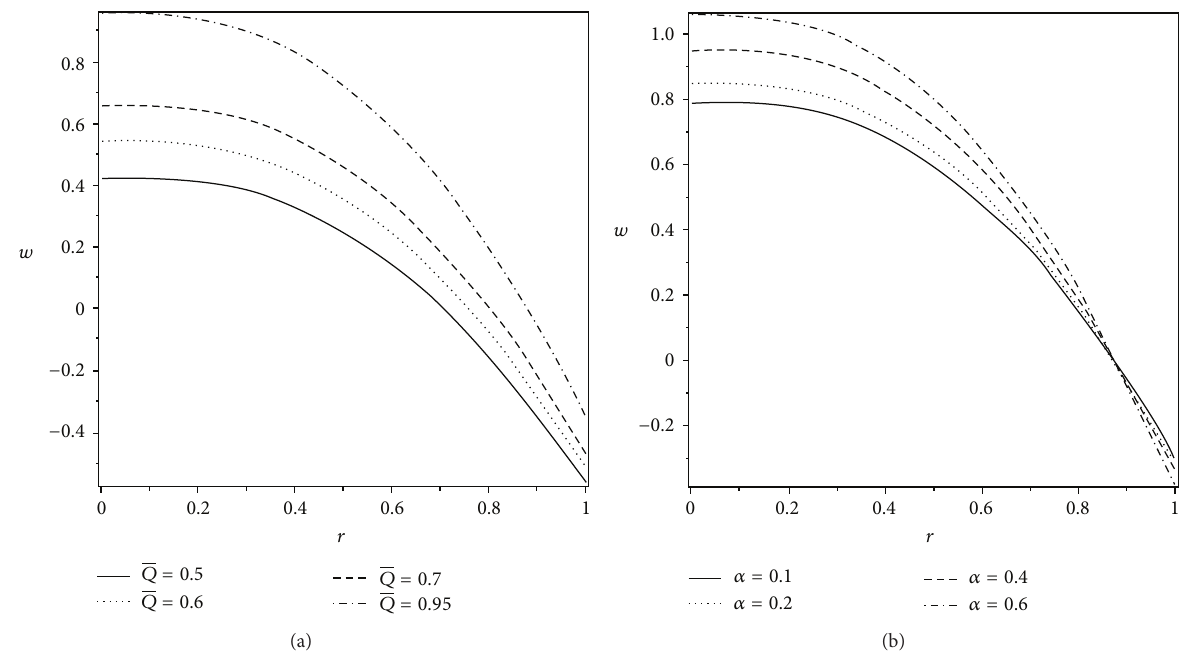
Figure 9: Variation of axial velocity 𝑤 at 𝑧 = 1 for different values of (a) 𝛼 when 𝑄 = 0.95 and (b) 𝑄 when 𝛼 = 0.4 . The other parameters are = 0.05 , 𝛽 = 0.4 , and 𝜀 = 0.25 𝐻 𝑝